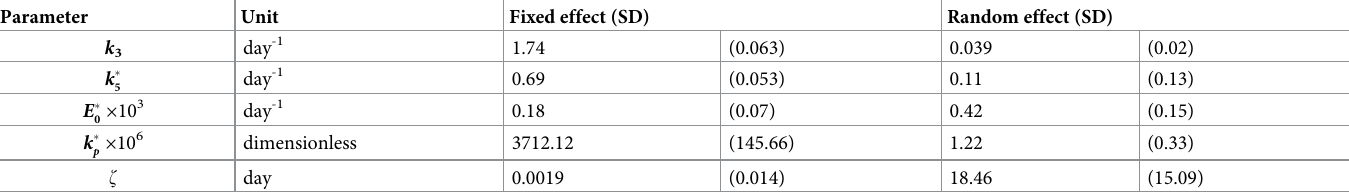
Table 5. Population parameters estimated by fitting the model to NP swab viral load data set from severely infected patients [60] (Fig